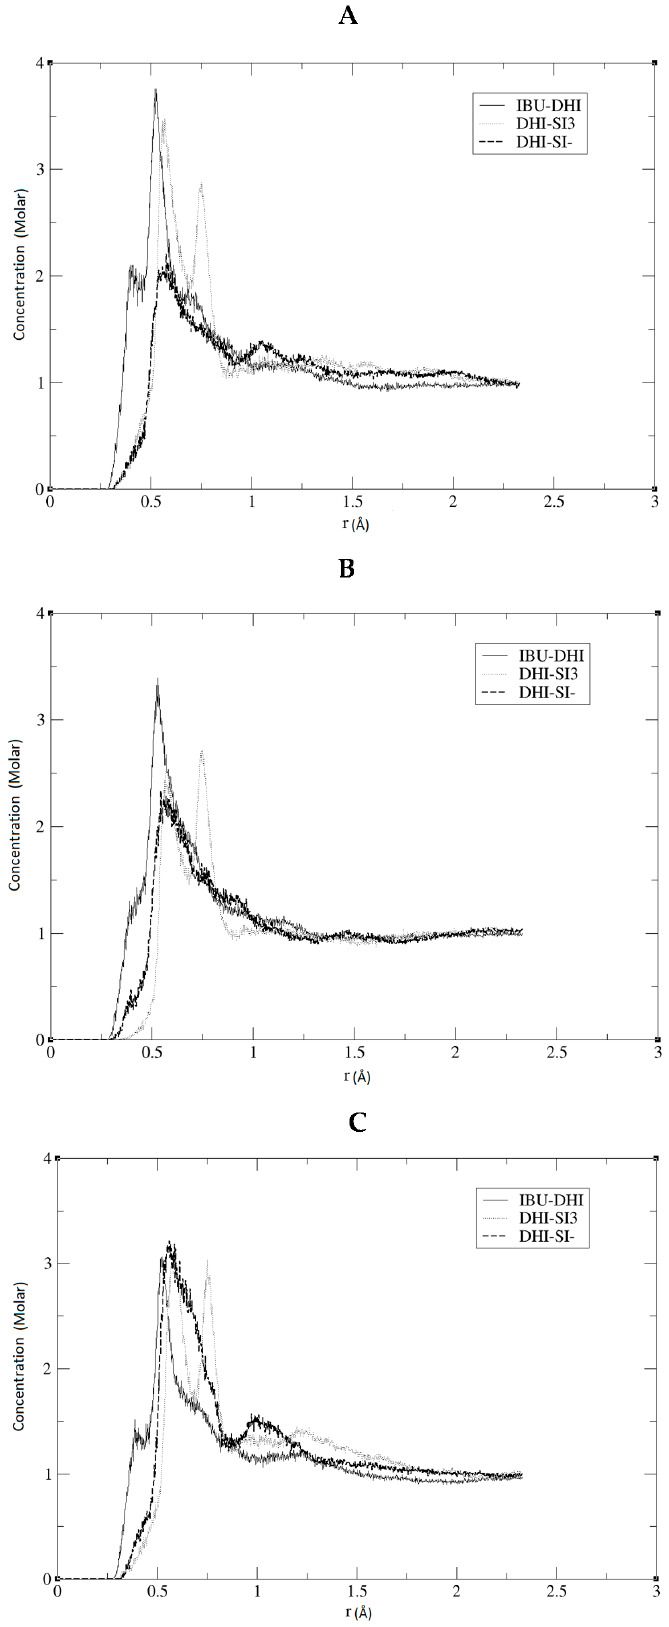
Figure 3. RDF analysis using the C atom of DHI for the pairs IBU-DHI, DHI-SI3, IBU-SI − . A , B and C represent the RDF of each MD replica.